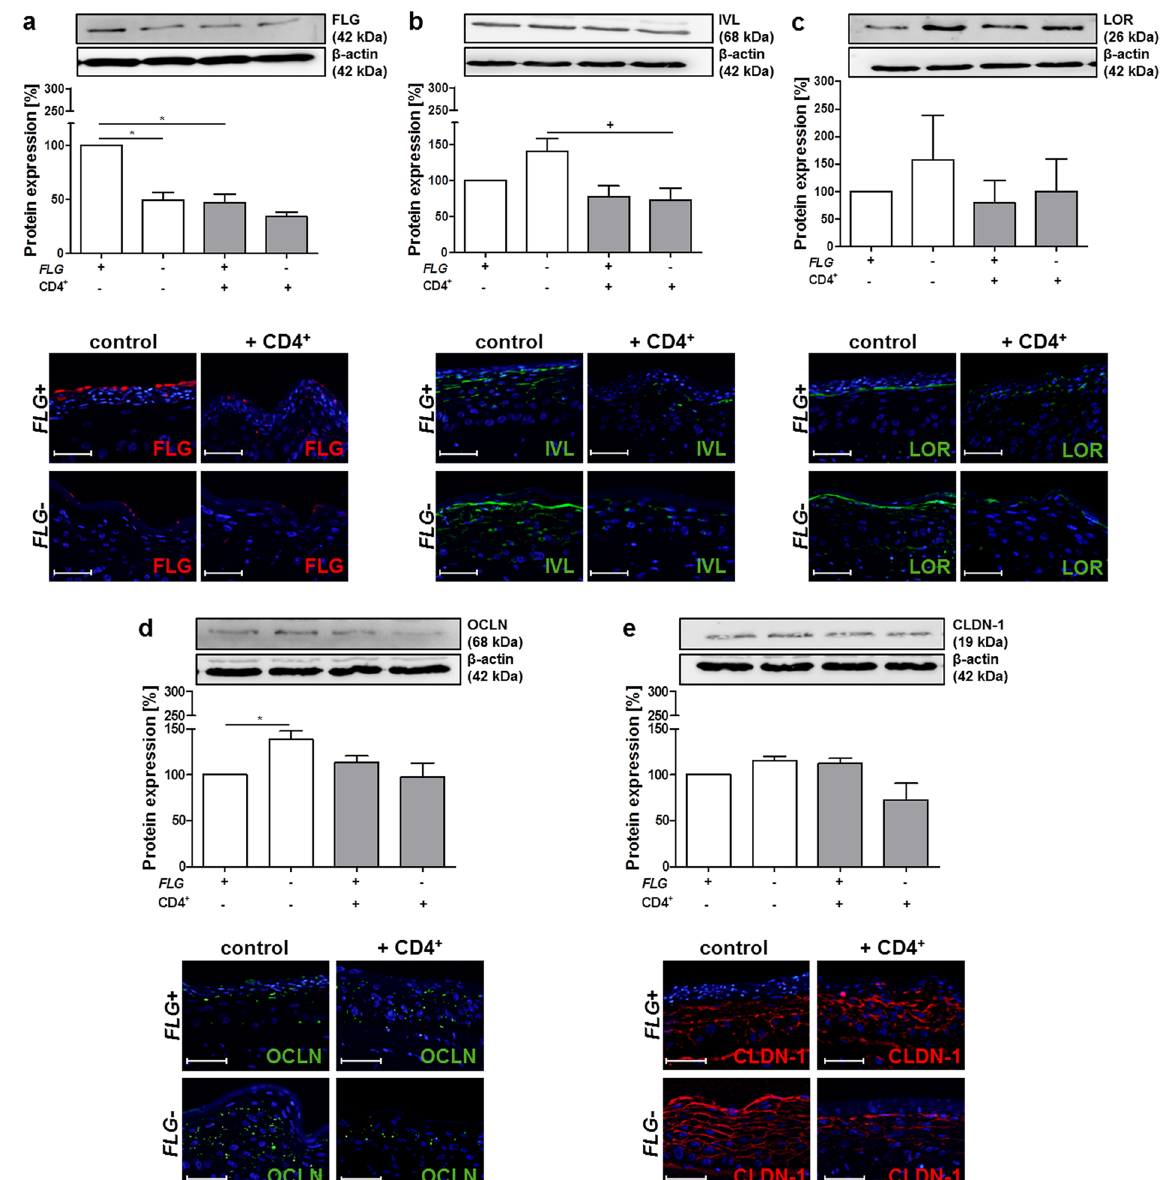
Figure 2. Exposure of activated CD4 + T cells to the skin equivalents reduces the expression of important skin barrier and tight junction proteins. Western blot and relative protein expression semi-quantified by densitometry, as well as representative immunostaining of normal ( FLG + ) and filaggrin-deficient ( FLG − ) skin equivalents alone and after addition of activated CD4 + T cells for ( a ) filaggrin (FLG, red), ( b ) involucrin (IVL, green), ( c ) loricrin (LOR, green), ( d ) occludin (OCLN, green) and ( e ) claudin-1 (CLDN-1, red). Counterstained with DAPI (blue), scale bar = 100 μ m. * Indicates statistically significant differences between FLG + skin equivalents ( * p ≤ 0.05), + indicates statistically significant differences between FLG − skin equivalents ( + p ≤ 0.05). (Mean ± SEM; n =